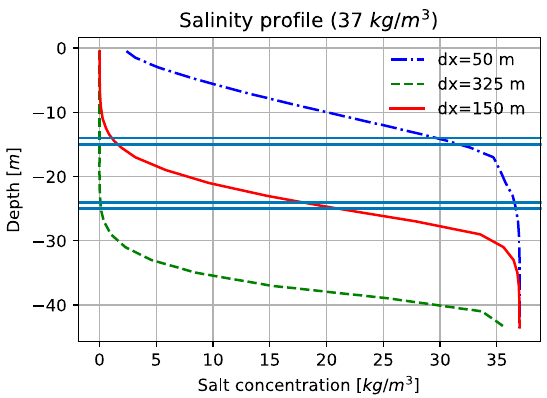
Figure 12. Salinity profile at row j = 16 as a function of the depth at di ff erent distances from the sea (0.0m). The blue line, the red bold line and the orange line correspond to a distance of 50 m, 150 m and 325 m, respectively, from the sea boundary. And a salt concentration at the boundary of: ( a ) 37 kg/m 3 ; ( b ) 35 kg/m 3 ; ( c ) 30 kg/m 3 ; ( d ) 20 kg/m 3 ; ( e ) 10 kg/m 3 .